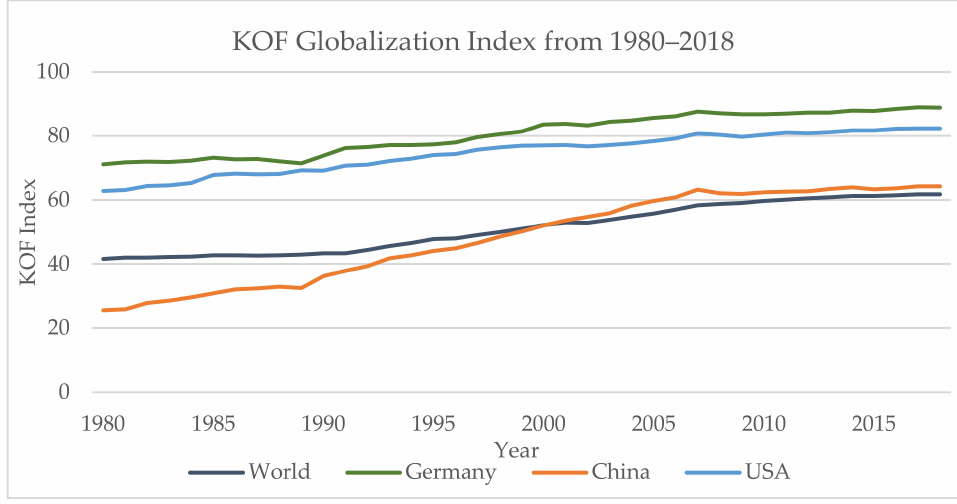
Figure 1. KOF Globalization Index. Own illustration based on